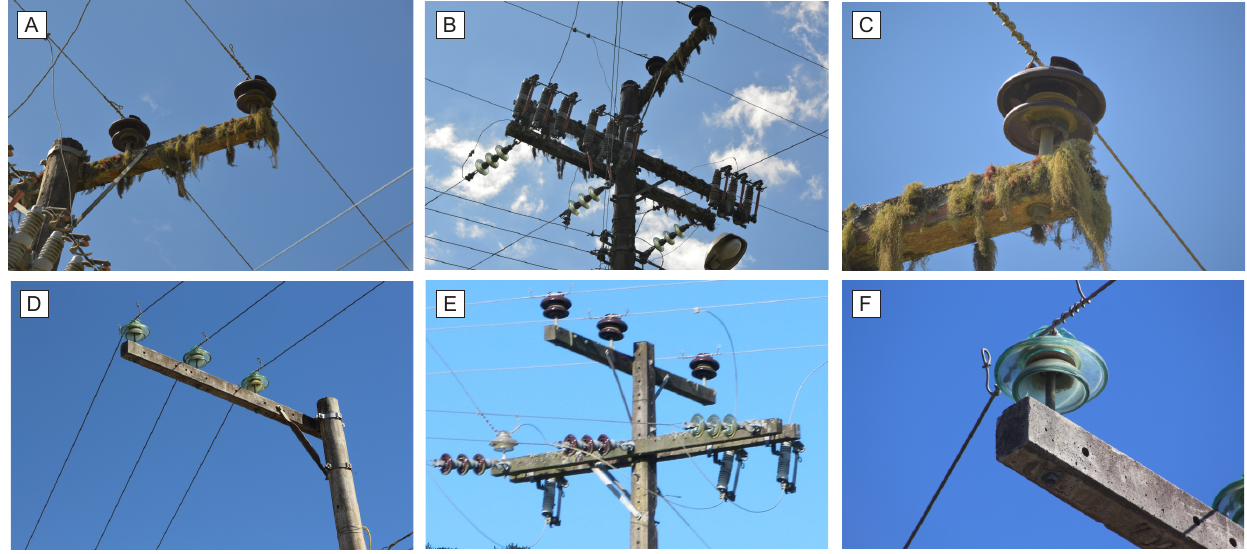
Figure 1. Images of inspections of electric power distribution network. The photographs recorded during inspections of the electrical power system are taken at different positions, with variations in the image approximation in relation to the network components. The photographs are intended to highlight the conditions of the insulating components, which are responsible for insulating the distribution system and the supporting structure of the